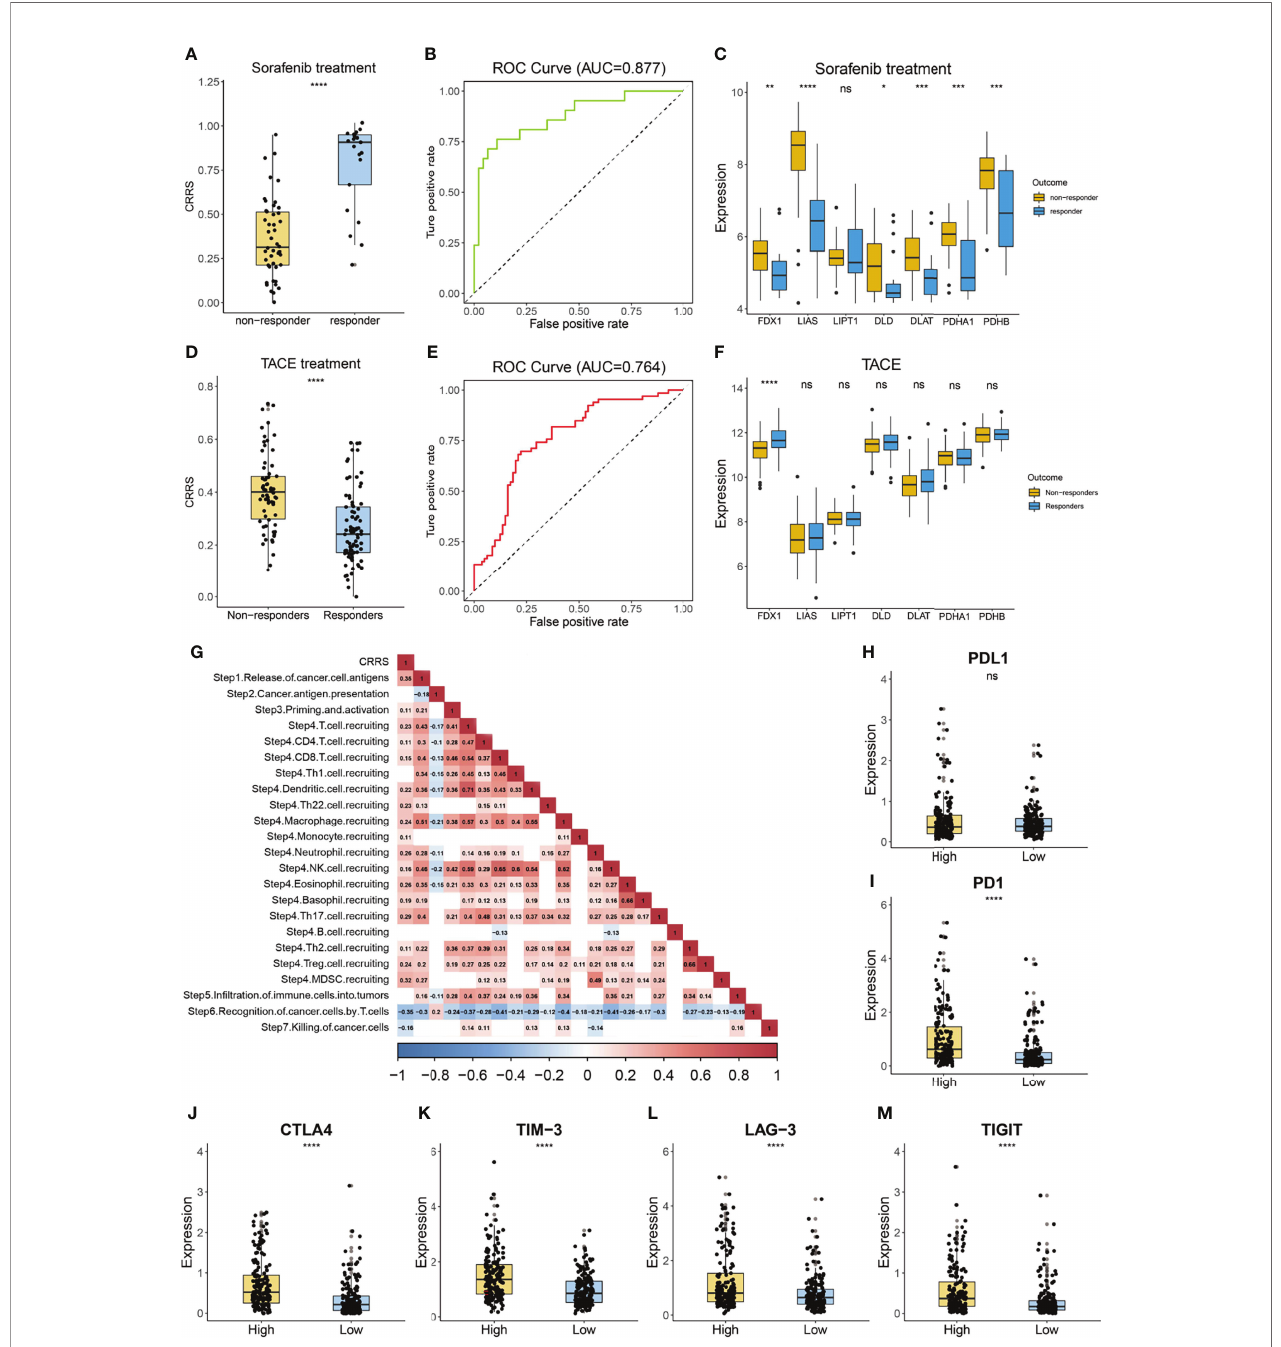
FIGURE 7 | Guidance of CRRS in the therapy for HCC patients. (A) The box and dot plot showing the value of CRRS between responders and non-responders to sorafenib. Wilcoxon test was used for data analyses. (B) The AUC value of CRRS in predicting the ef fi ciency of sorafenib in HCC patients. (C) The boxplot showing the expression of cuproptosis-related genes in the responders and non-responders to sorafenib. Wilcoxon test was used for data analyses. (D) The box and dot plot showing the value of CRRS between responders and non-responders to TACE. Wilcoxon test was used for data analyses. (E) The AUC value of CRRS in predicting ef fi ciency of TACE in HCC patients. (F) The boxplot showing the expression of cuproptosis-related genes in responders and non-responders to TACE. Wilcoxon test was used for data analyses. (G) Correlation between CRRS and immune activity scores of each step of the Cancer-Immunity Cycle. Data were analyzed using Pearson correlation analysis. (H – M) The box and dot plot showing the expression of PDL1 (H) , PD-1 (I) , CTLA-4 (J) , TIM-3 (K) , LAG-3 (L) , and TIGIT (M) between HCC patients from the low- or high-CRRS subgroups. Wilcoxon test was used for data analyses. The p values were shown as *p < 0.05, **p < 0.01, ***p < 0.001, and ****p < 0.0001. ns for not signi fi